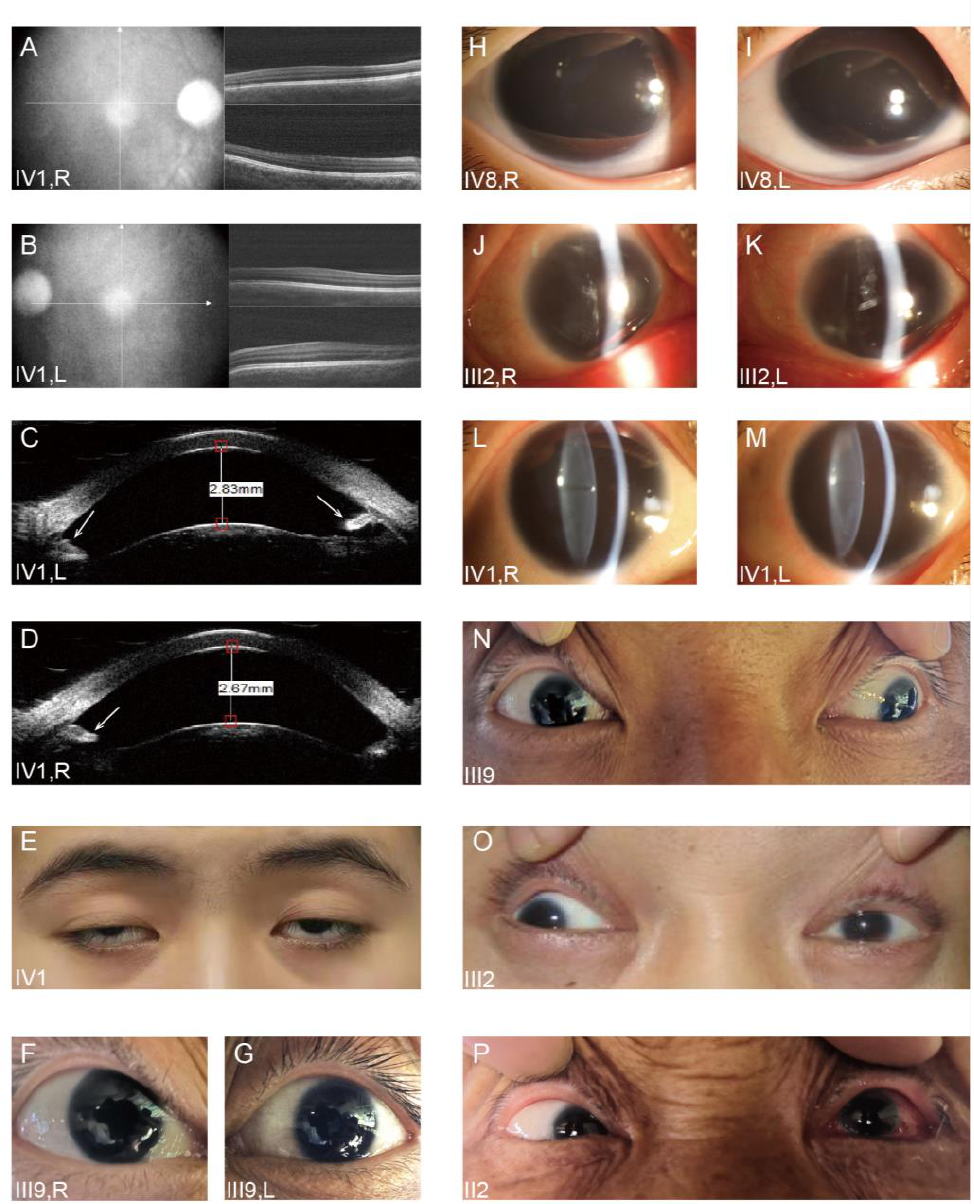
Figure 2. Representative photos of partial cases. ( A , B ) Optical coherence tomography images from the proband (IV1) demonstrated foveal hypoplasia in both the right eye ( A ) and the left eye ( B ). ( C , D ) Ultrasound biomicroscope photos displayed the iris remnants (the arrow) in the anterior chamber of the proband (IV1) in both eyes. ( E ) Ptosis was present in the proband (IV1). ( F , G ) Photos revealed total iris hypoplasia in both eyes of patient III9. ( H , I ) Anterior segment photographs indicated that both eyes of the proband IV8 exhibited complete iris absence. ( J , K ) The eyes of patient III2 were found with peripheral corneal edema and opacity, total iris hypoplasia, and aphakia by anterior segment photography. ( L , M ) Bilateral aniridia and cataract were observed in the proband (IV1). ( N , O , P ) Eye position photographs manifested that patient III9 ( N ) and patient III2 ( O ) suffered from exotropia, while patient II2 ( P ) developed